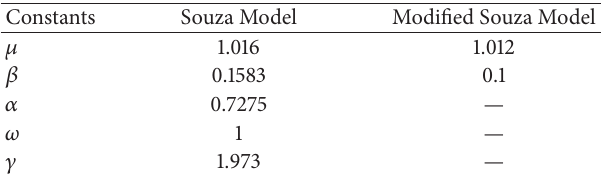
Figure 3: Vertical wind profile for K34 (blue line) and ATTO triangular tower (red line). The horizontal lines represent the standard deviation for each measurement point. The logarithmic profile was obtained through the equation 𝑢 = (𝑢 ∗ /𝑘) ln ((𝑧 − 𝑑)/𝑧 0 ) , where 𝑘 is von Karman’s constant, 𝑧 0 = (1/30)ℎ is roughness length, and 𝑑 = 0.75ℎ is displacement height [17]. Table 2: Souza Models fit